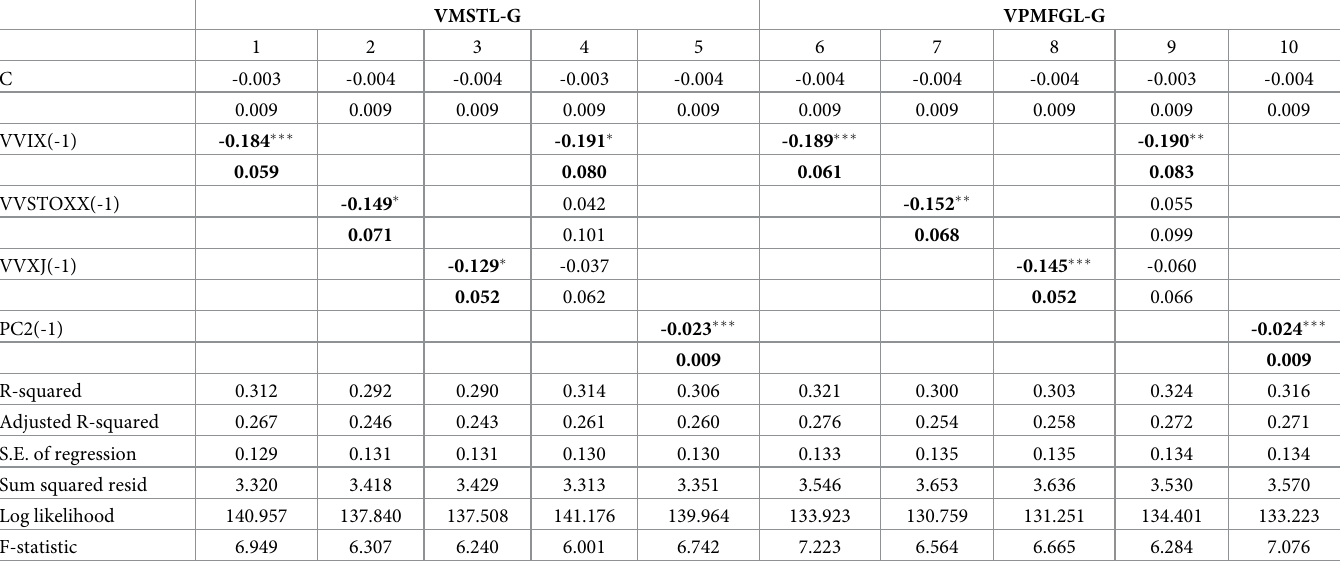
Table 4. Forecast variation in MSTL and PMFGL with volatility